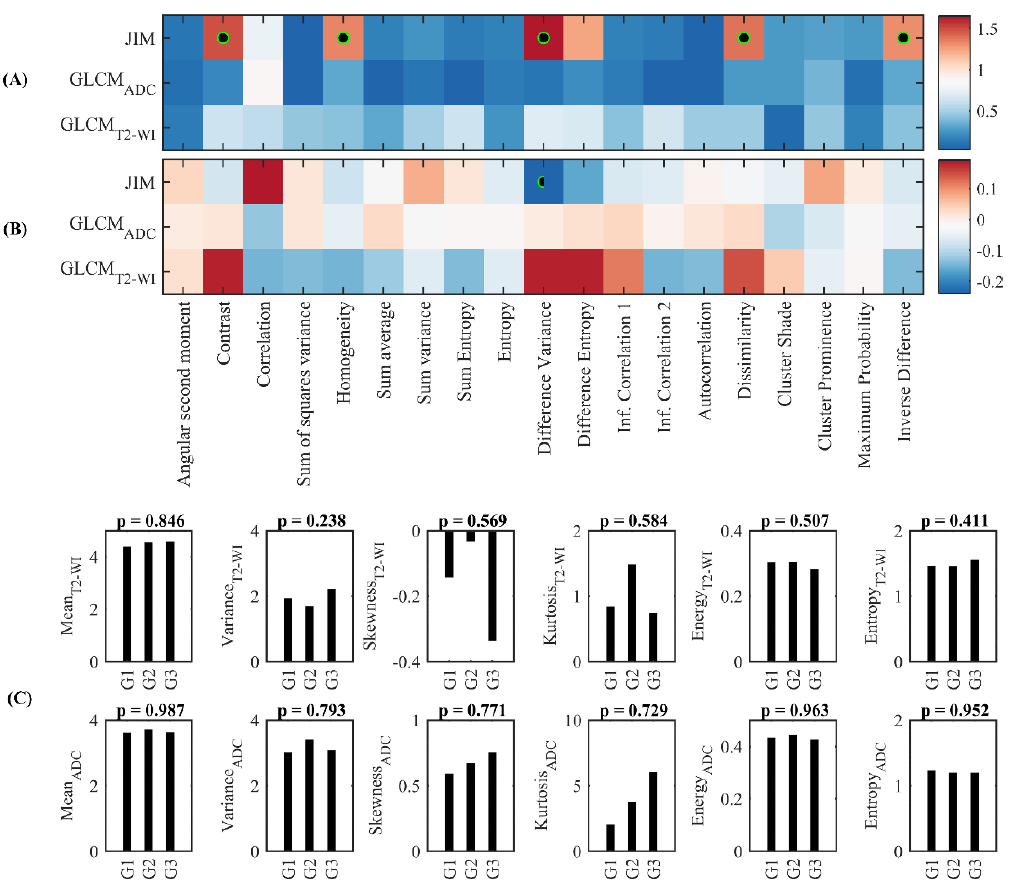
Figure 2. Univariate prediction of GS using texture features ( A ) Kruskal-Wallis significance test compared the three GS groupings. ( B ) Spearman’s rank correlation coefficient between texture features and the GS groupings. Significant features ( p < 0.05) are indicated with a black-green circle. ( C ) Average of the histogram features derived from T2-WI (i.e., first row) and ADC (i.e., second row) image value (Histogram features: Mean, Variance, Skewness, Kurtosis, Energy, and Entropy) across the three groups of GS (i.e., G1, G2, and G3).